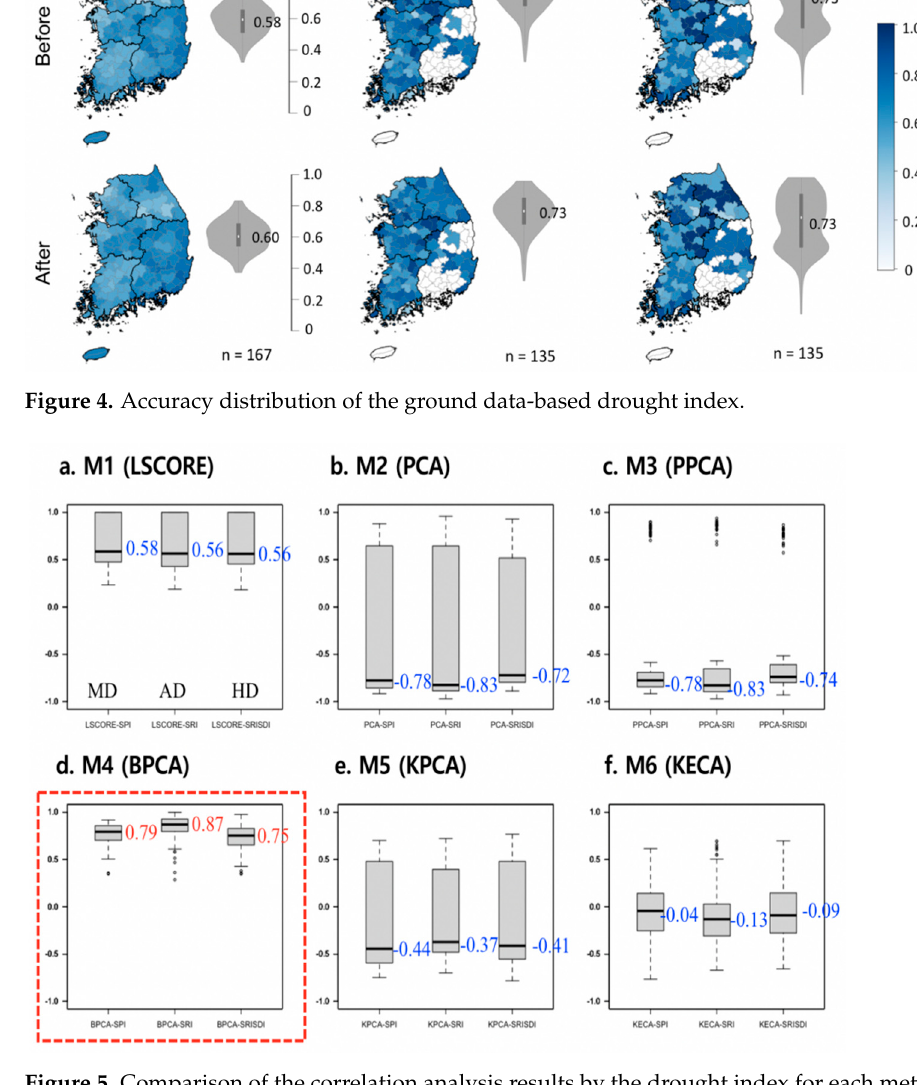
Figure 5. Comparison of the correlation analysis results by the drought index for each method.